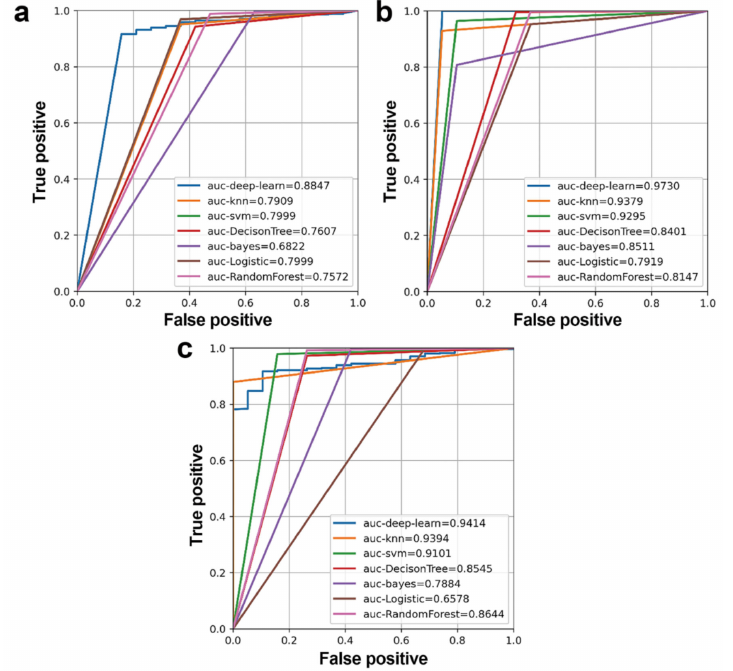
Figure 12. ROC curves and AUC values of regulatory modules for lung adenocarcinoma for the independent dataset using different machine learning methods. ( a – c ) are results for three regulatory modules for lung adenocarcinoma a, b, and c,